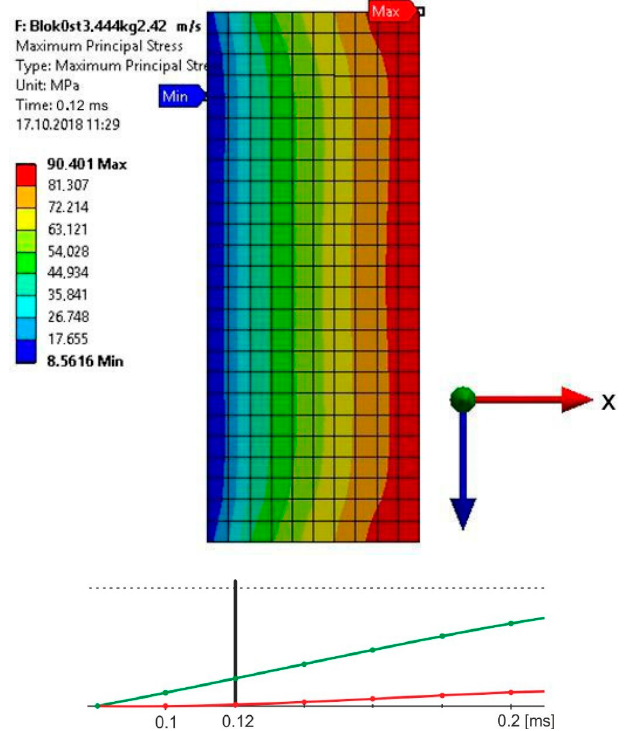
Figure 6. Maximum principal stress distribution for the computing time of 0.12 ms in the joint, loaded with energy 10 J, at a speed of 2.42 m /